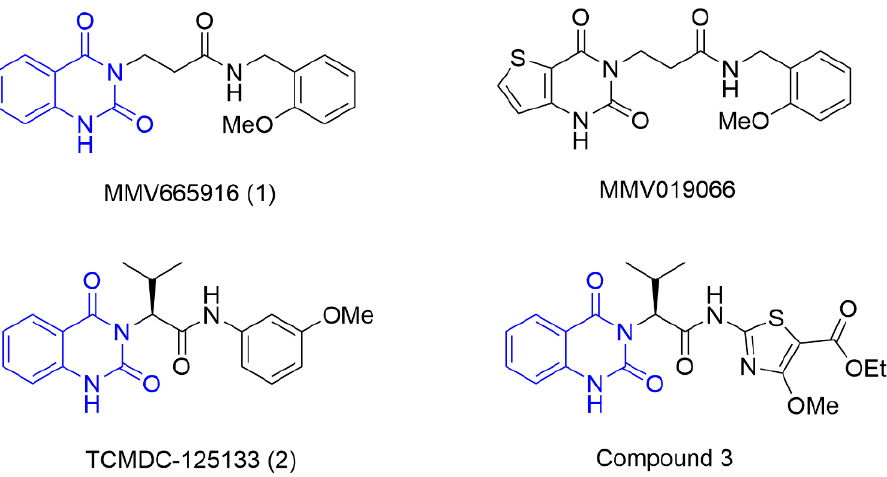
Figure 1. Structures of MMV665916, MMV019066, TCMDC-125133, and compound 3 with their quinazolinedione moiety highlighted in blue.